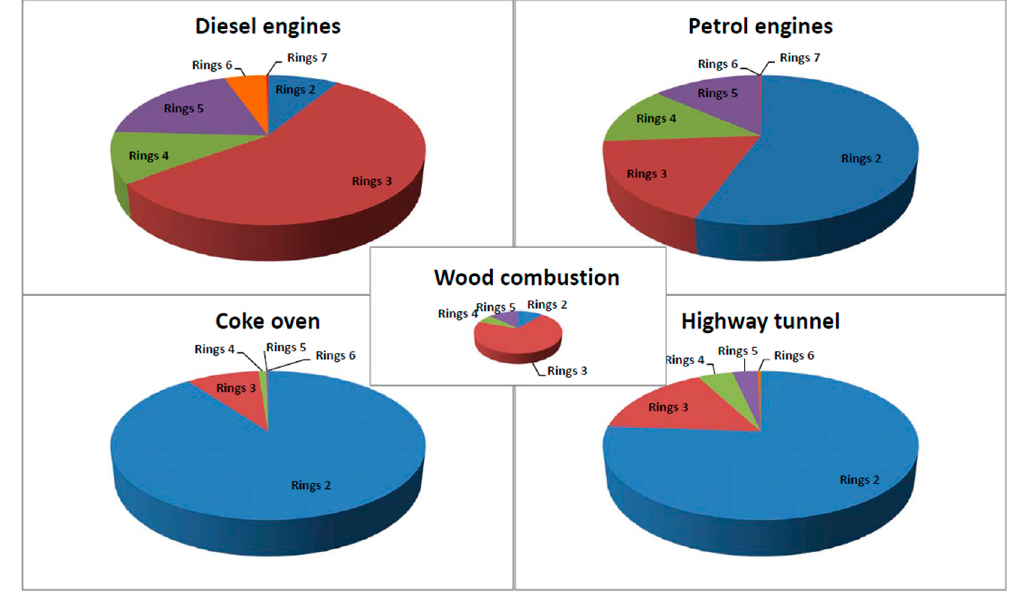
Figure 7. Source distribution of percentage PAHs to total mass [29] (total concentration of the measured 20 PAHs from highway tunnels, diesel engine, petrol engines, coke oven, and wood combustion in air samples, respectively).